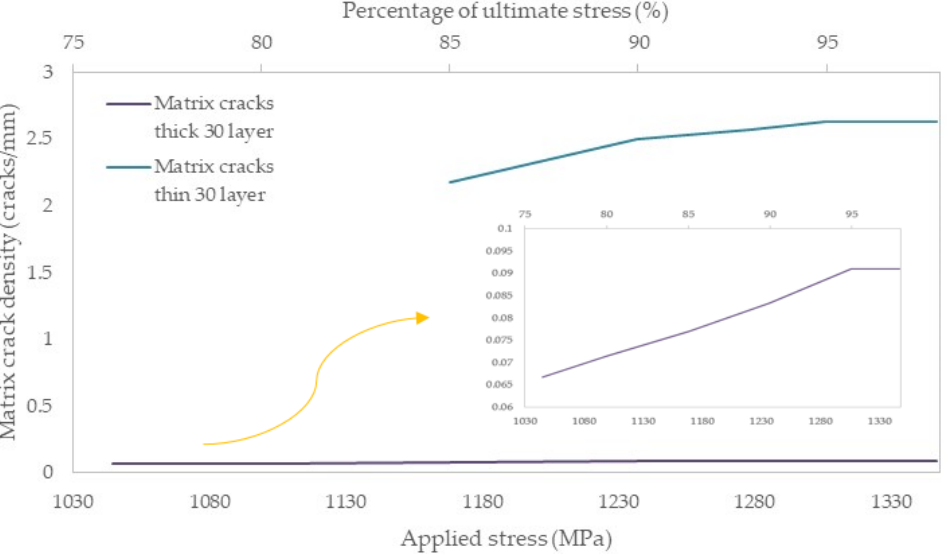
Figure 11. Increase of matrix crack density in the [0°/30°] 2s laminates.